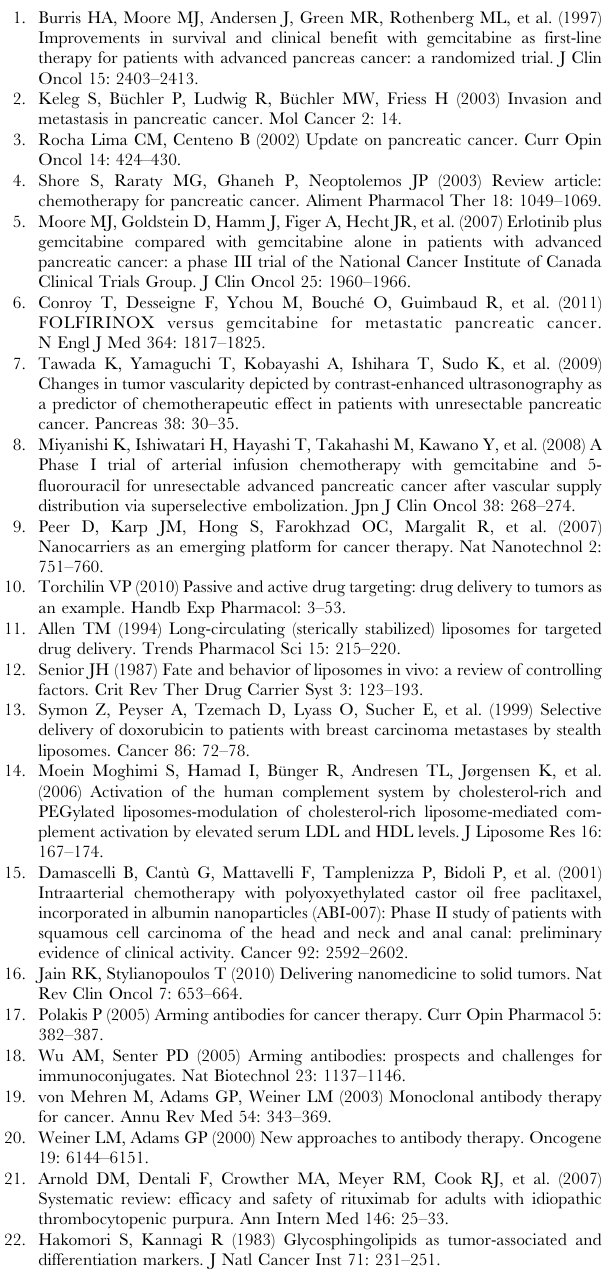
Table S4 Hematological and non-hematological ad- verse effects during Fuc-Liposome-Cisplatin adminis- tration. (TIFF) Text S1 This file includes Supporting Materials and Mehods with references.